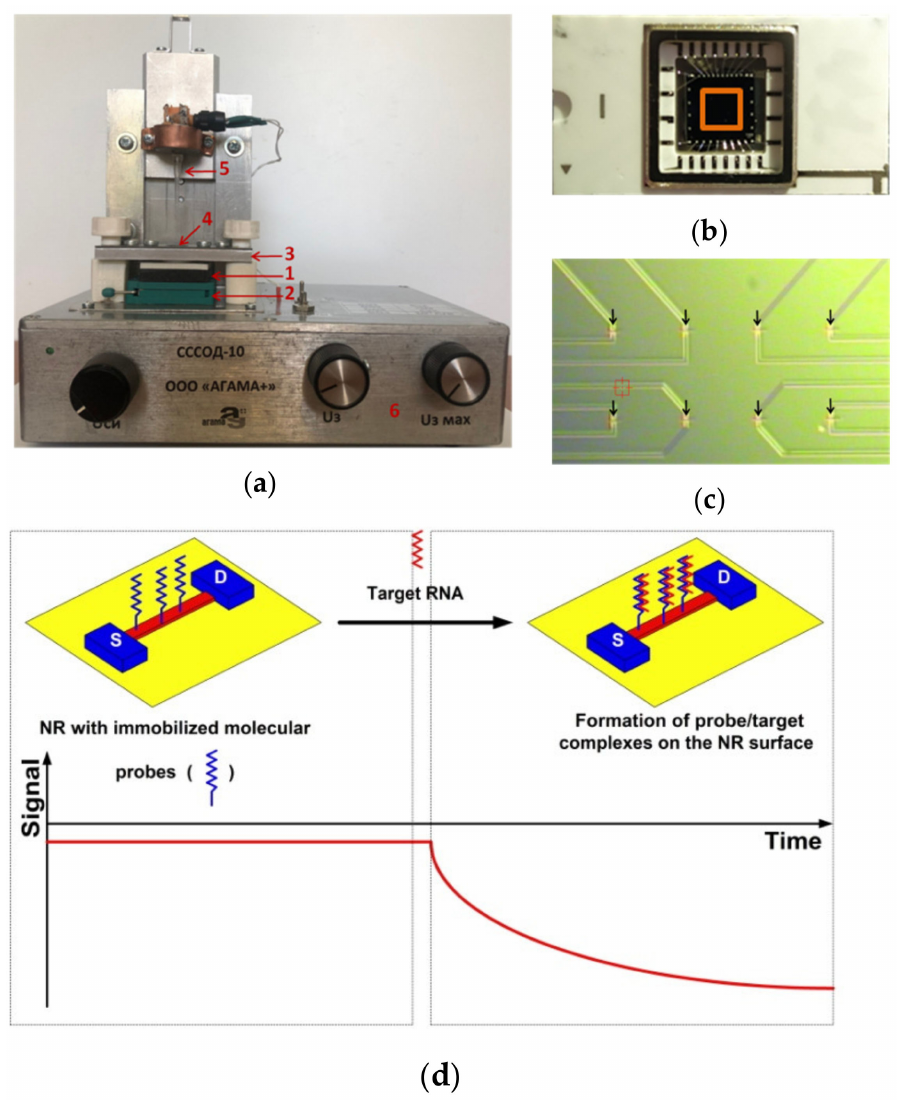
Figure 1. Photographic images of the entire analytical module of the NR biosensor ( a ), the SOI-NR sensor chip assembly (top view; red square indicates the sensitive area of the chip) ( b ), and the surface of the SOI-NR sensor chip with the array of NRs (arrows indicate the topography of the NRs) ( c ). Numbers indicate the main elements of the biosensor: 1—silicon-on-insulator nanoribbon sensor chip; 2—chip holder; 3—measuring cell holder; 4—measuring cell; 5—stirrer; 6—ten-channel data collection and storage system. Panel ( d ) displays a schematic of the principle of the real-time NR- based RNA detection. The conductance of the NR (and, accordingly, the biosensor signal) changes at the expense of the interaction between the NR-immobilized molecular probes and the target RNA molecules in the analyzed